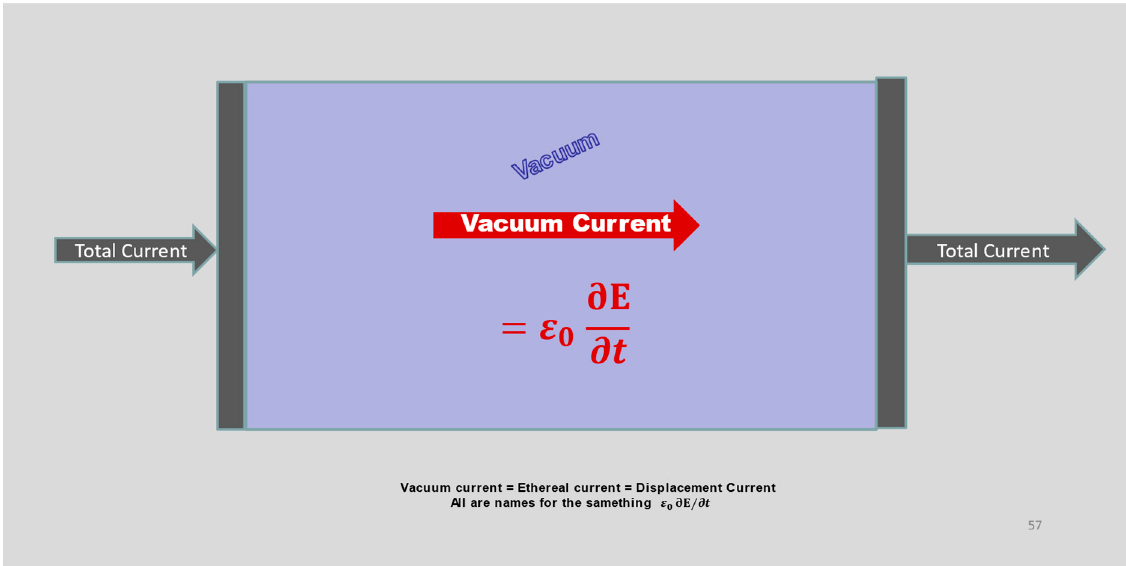
Figure 3. The vacuum capacitor illustrates the equality of total current.